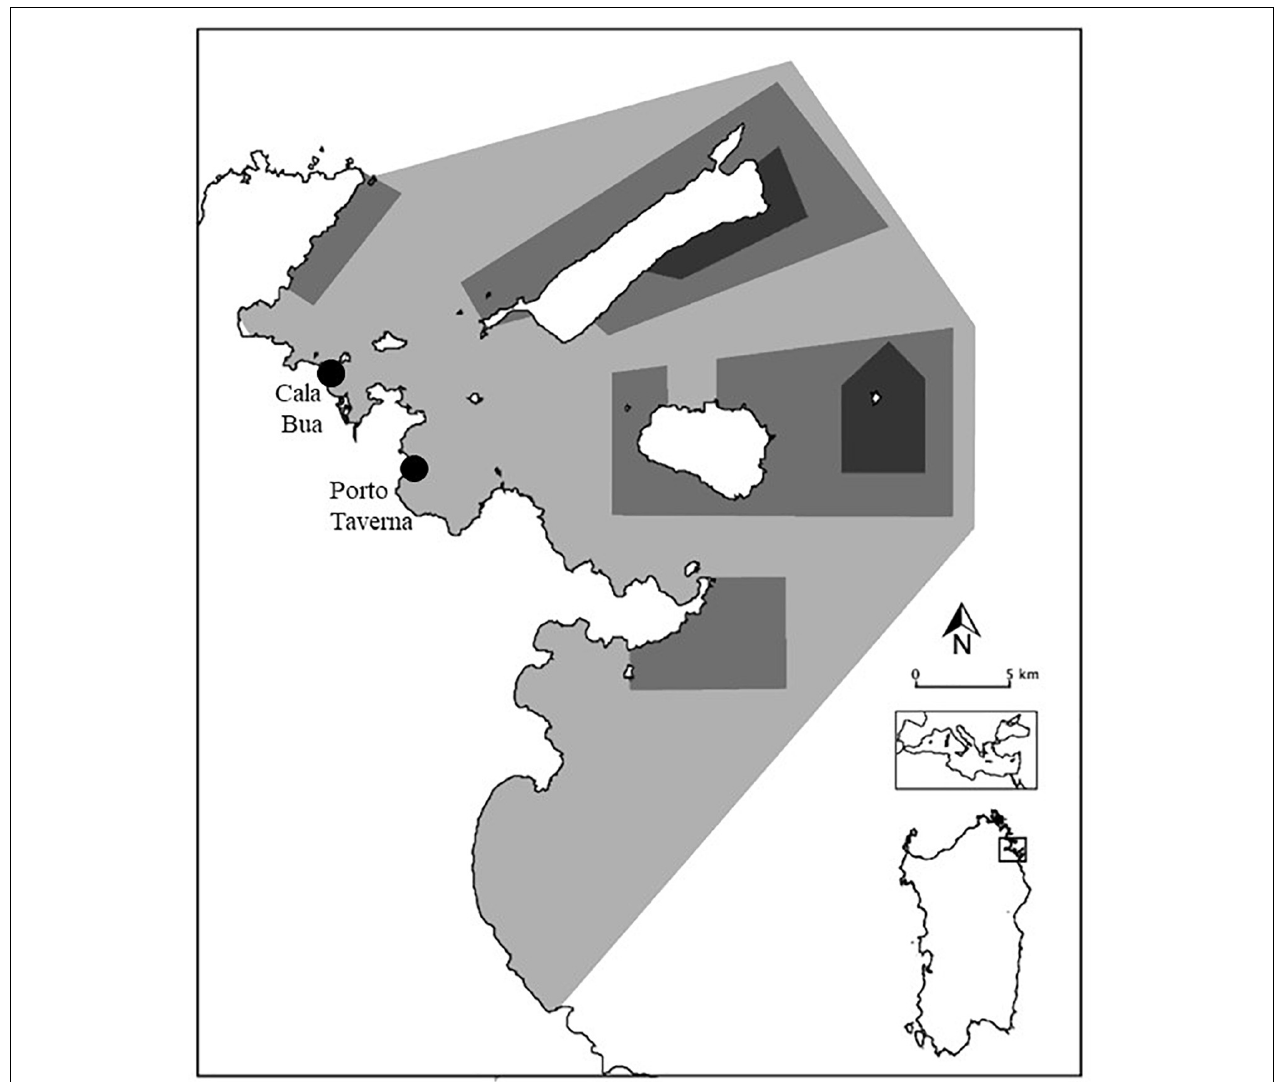
FIGURE 1 | Map of Tavolara Punta Coda Cavallo MPA with the detailed position of the two considered study sites.